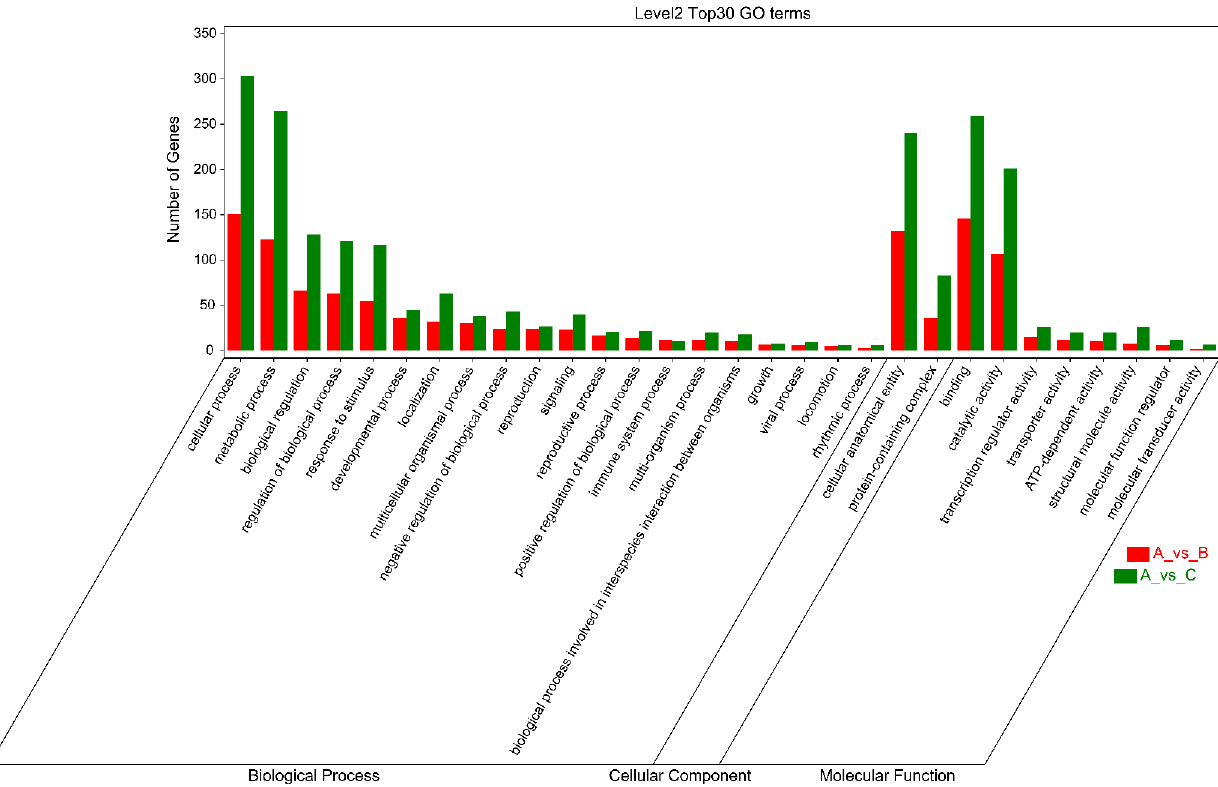
Figure 6. Cluster map for GO enrichment analysis of selected genes. A, P. neoveitchi ; B, P. wilsonii ; C, P. likiangensis .